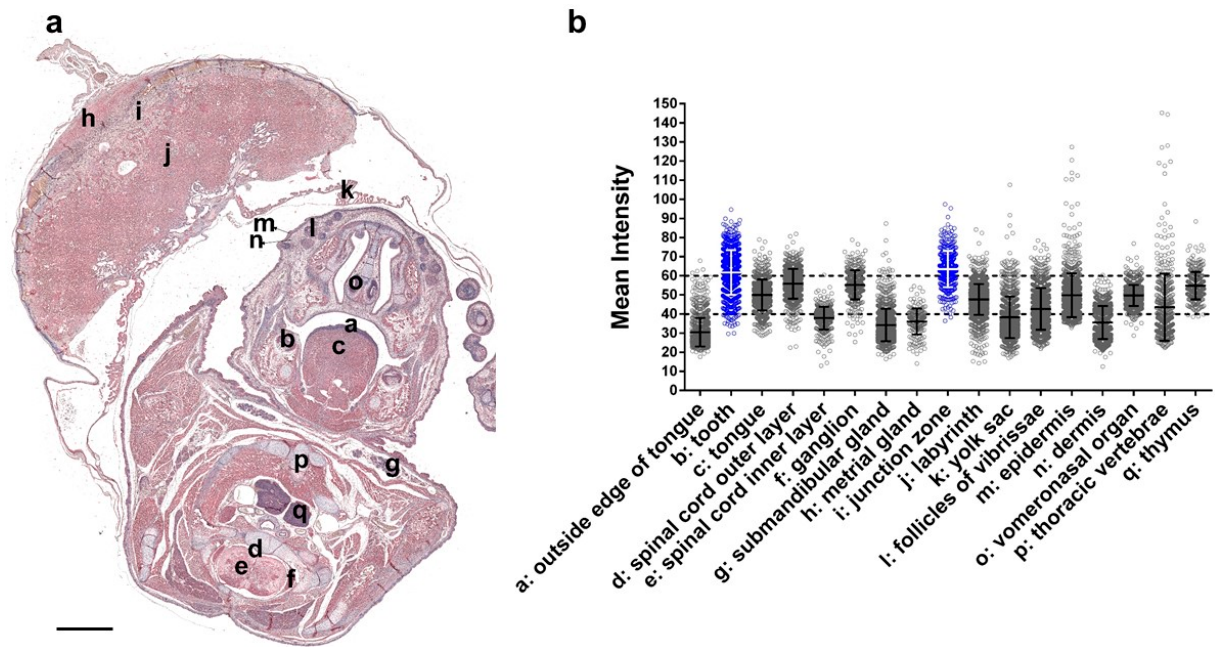
Figure 6. Expression levels of QSOX1 in various embryonic tissues at 17.5 dpc. ( a ) A representative cross-section image of QSOX1 distribution in the 17.5 dpc embryo. The marks (a to q) indicate the tissues subjected to quantify and their locations. Scale bar = 1 mm. ( b ) The scatter plot shows the mean intensity of QSOX1 in cells of each tissue; every small circle indicates the expression intensity of QSOX1 in a single cell. Statistical comparison on expression levels among tissues is provided in the Supplementary Materials, Table S2.